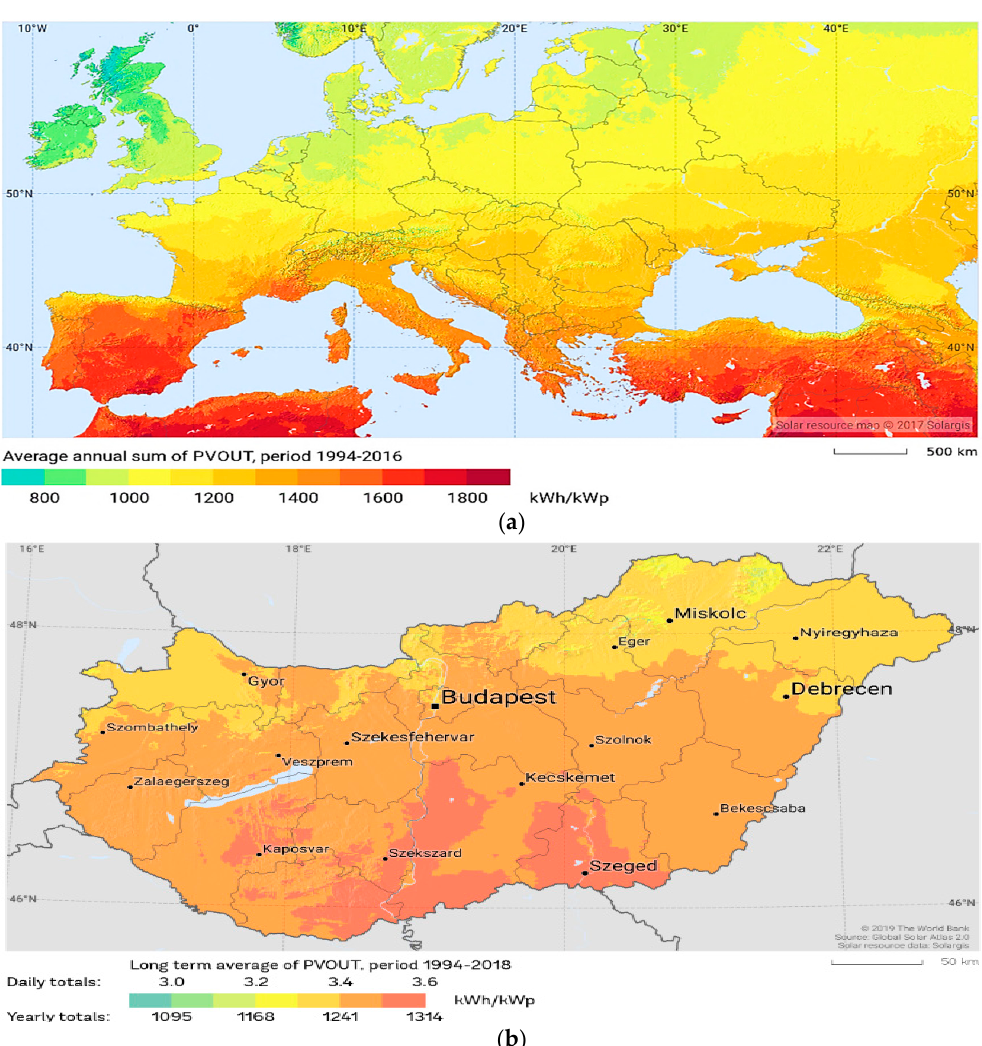
Figure 1. The photovoltaic power potential, Europe ( a ) and Hungary ( b ) [18].